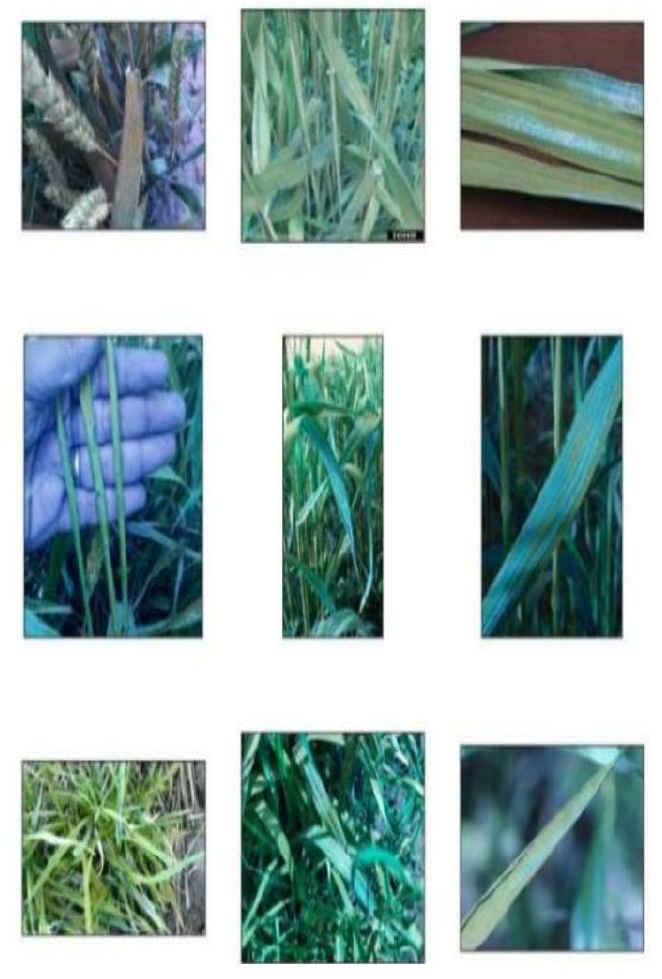
Figure 2. Wheat-leaf training